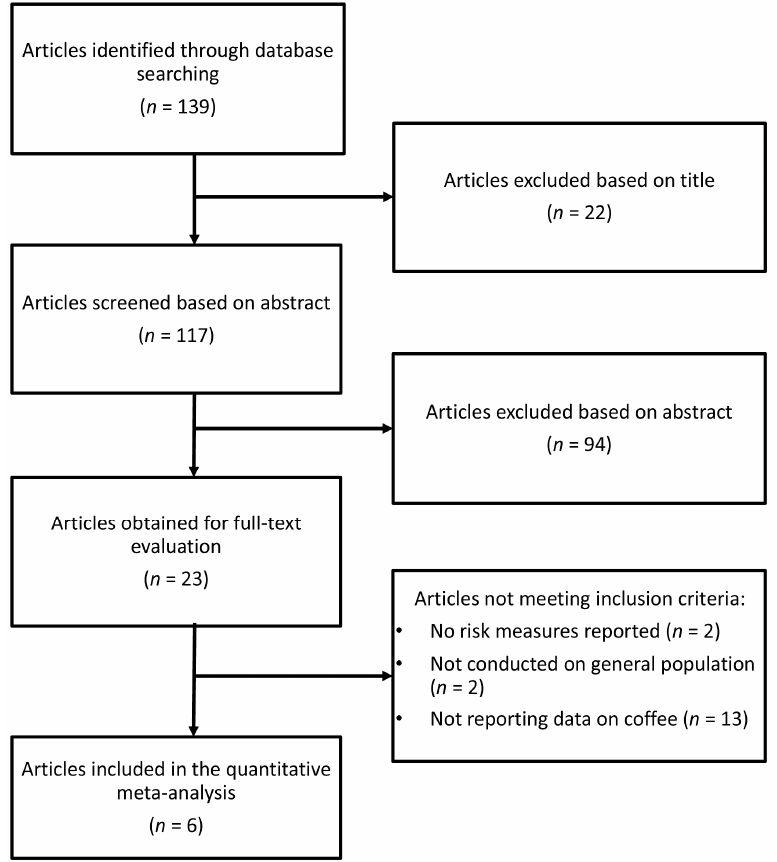
Figure 1. Flowchart of study selection for inclusion in the meta-analysis.